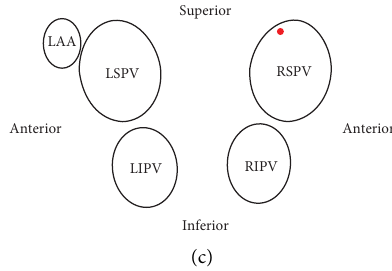
Figure 5: (a) In the prospective RFCA procedures, simultaneously recorded spike potential and abrupt rise in impedance with concomitant temperature and CF drop could timely detect the occurrence of “silent” SP. Te time from the initiation of RFCA to the occurrence of “nonaudible” SP was 17.4s. Te sudden impedance rise after 17.4s of RFCA coincided with a SP. After the “nonaudible” SP, an abrupt impedance rise of 10.7 Ω , temperature drop of 2.4 ° C, and CF drop of 18.1g were recorded. Te RFCA was terminated approximately 3.5s later. (b) A spike potential with a consequent PAC was recorded immediately during the occurrence of SP. (c) Te location of the SP is at the posterior-superior wall of the RSPV. Tis patient subsequently developed pericardial tamponade and underwent drainage. Te patient received a dual-chamber pacemaker for sick sinus syndrome 2 years ago. AP: atrial